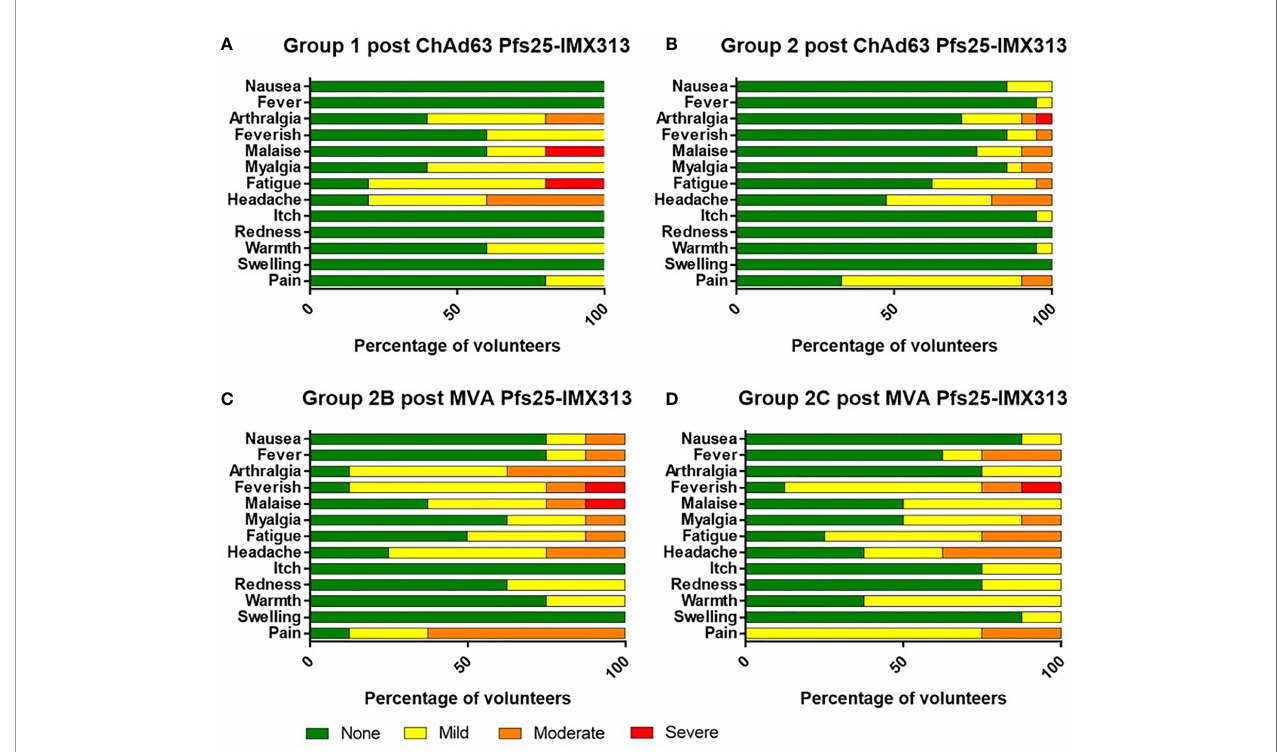
FIGURE 2 | Solicited AEs following vaccination with ChAd63 and MVA Pfs25-IMX313. The solicited local and systemic adverse events (AEs) recorded for 7 days following ChAd63 Pfs25-IMX313 and MVA Pfs25-IMX313 are shown at the maximum severity reported by all volunteers. (A) Five volunteers received 5 × 10 9 viral particles (vp) (Group 1), and (B) 21 received 5 × 10 10 vp (Group 2) of ChAd63 Pfs25-IMX313. (C) Eight of the Group 2 volunteers went on to receive 1 × 10 8 plaque- forming units (pfu) (Group 2B), or (D) Eight Group 2 volunteers received 2 × 10 8 pfu (Group 2C) of MVA